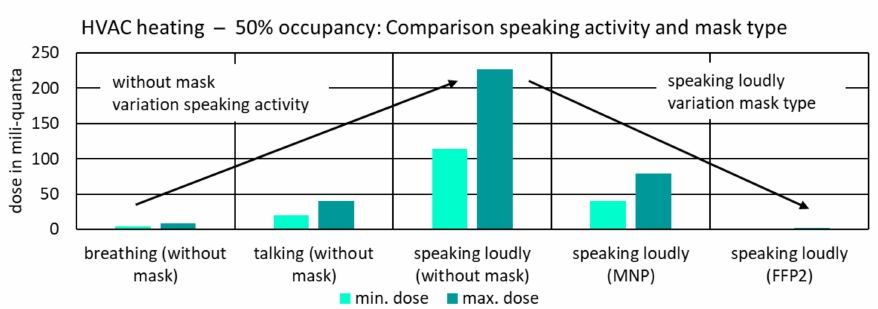
Figure 9. Comparison of inhaled dose in mili-quanta after 2.5 h in ICE with an infected person during different activities (breathing, talking or speaking loudly) of the emitter and with different mask types (none, MNP or FFP2): min. dose, minimum dose absorbed farther away from the emitter; max. dose, maximum exposure that is absorbed close to the